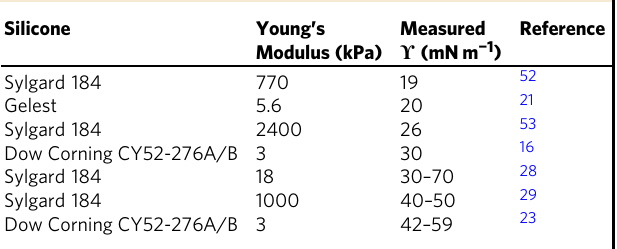
Table 1 Measured values of surface stress of similar silicone gels published in the